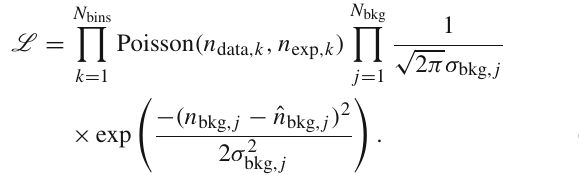
ple include systematic uncertainties for the data-driven backgrounds ( W +jets and fake leptons) and theory uncertainties for the t ¯ t signal